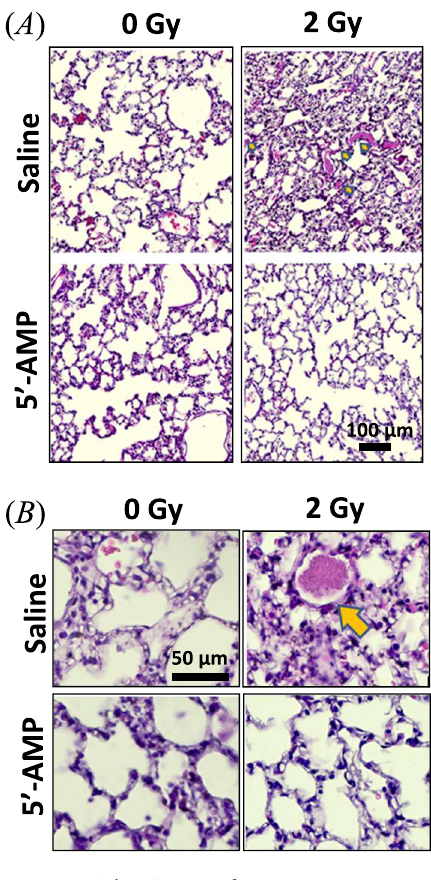
Figure 4. The 5 ′ -AMP administration in rats suppresses the radiation-induced early damage to the lung tissue. ( A ) The H&E staining of lung tissues showed evident alteration one week after 2 Gy whole-body C-ions irradiation. ( B ) Proteinosis are observed in irradiated rats’ pulmonary alveoli, while the 5 ′ -AMP treated rats have fewer proteinosis. Sham treatment, n = 3 animals; 5 ′ -AMP, n = 4 animals; Saline + 2 Gy, n = 4 animals; 5 ′ -AMP + 2 Gy, n = 4